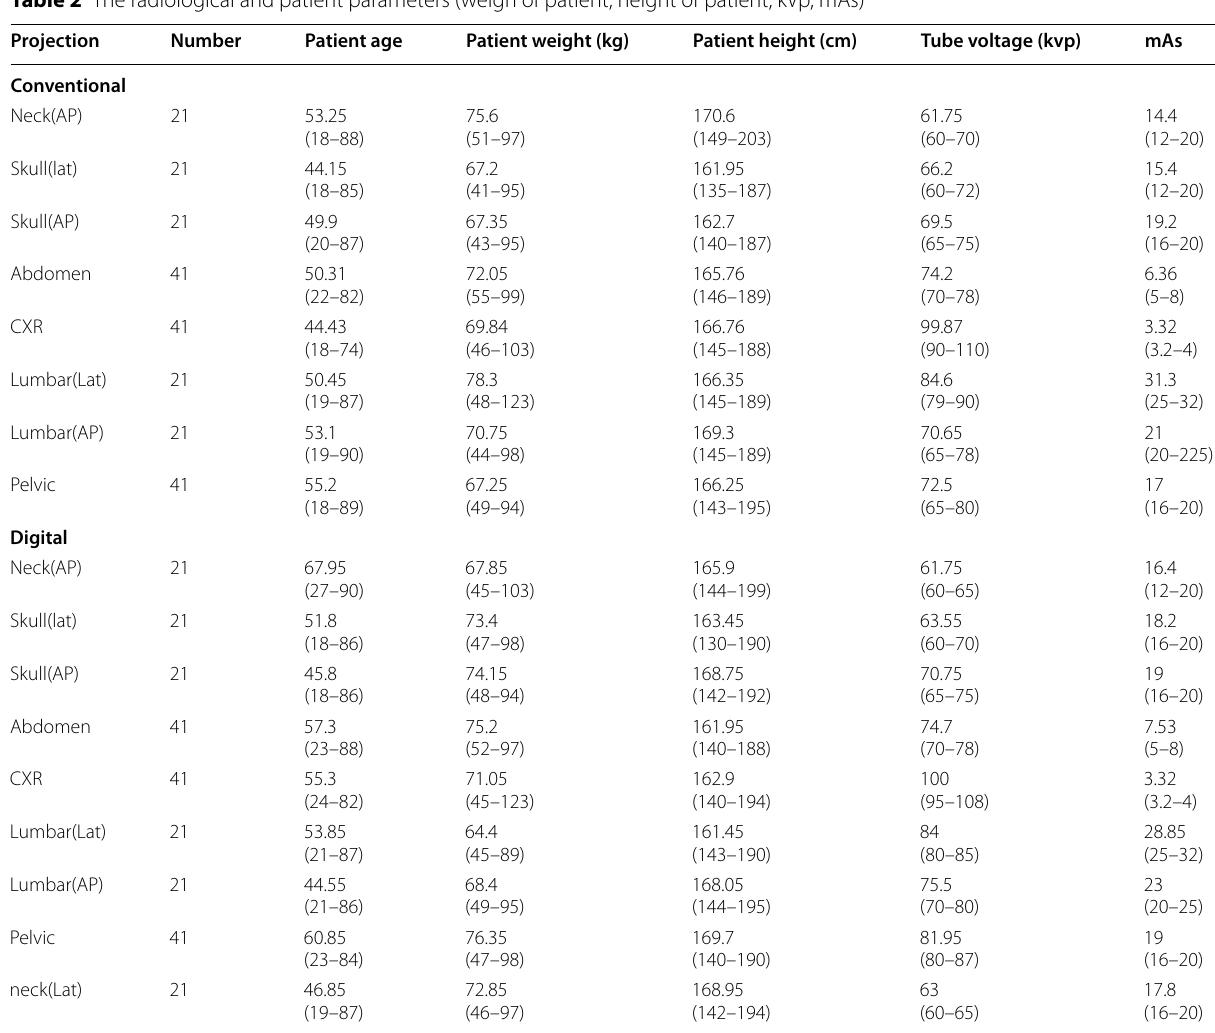
Table 2 The radiological and patient parameters (weigh of patient, height of patient, kVp, mAs)